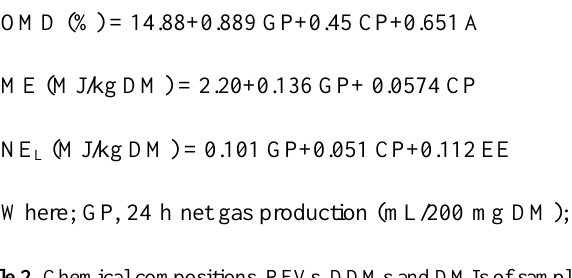
Table 2. Chemical compositions, RFVs, DDMs and DMIs of samples used in the study Plants Lotus